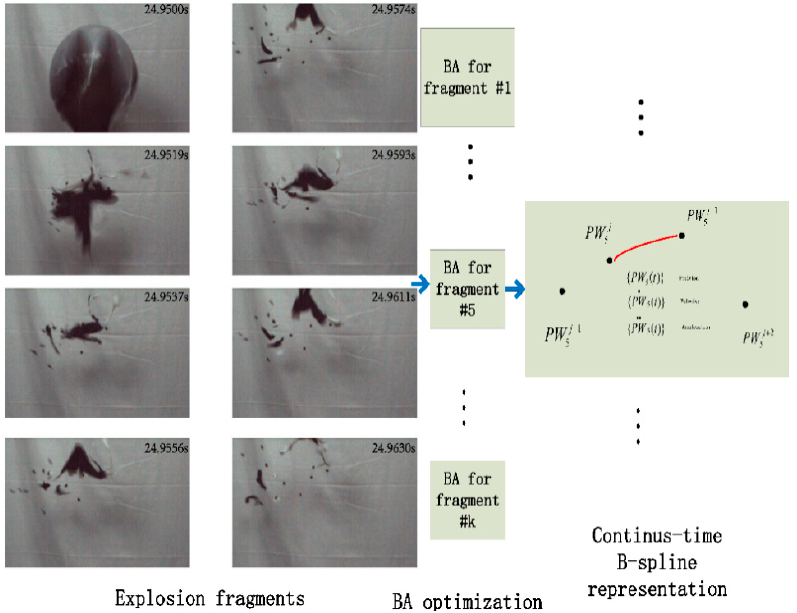
Figure 1. Continuous ‐ time motion estimation using bundle adjustment (BA) and B ‐ spline repre ‐ sentation.